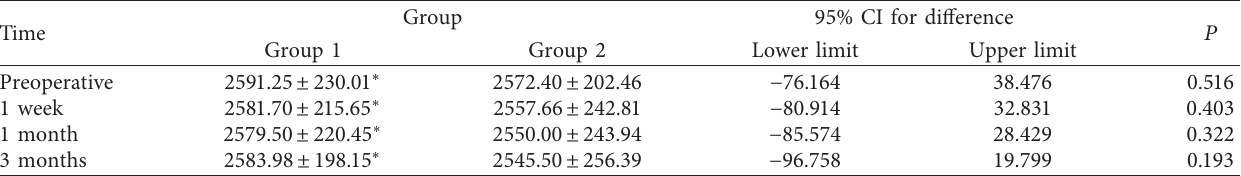
Figure 1: (a) Visual outcomes at 3 months postoperatively. (b) Spherical equivalent refraction attempted vs. achieved in group 1. (c) Spherical equivalent refraction attempted vs. achieved in group 2. (d) Spherical equivalent refraction accuracy. (e) Spherical equivalent refraction stability. UDVA, uncorrected distance visual acuity; CDVA, corrected distance visual acuity; SE, spherical equivalent; D, diopters; SD, standard deviation. Table 2: The comparison between the corneal endothelial cell count (cells/mm 2 ) of the two